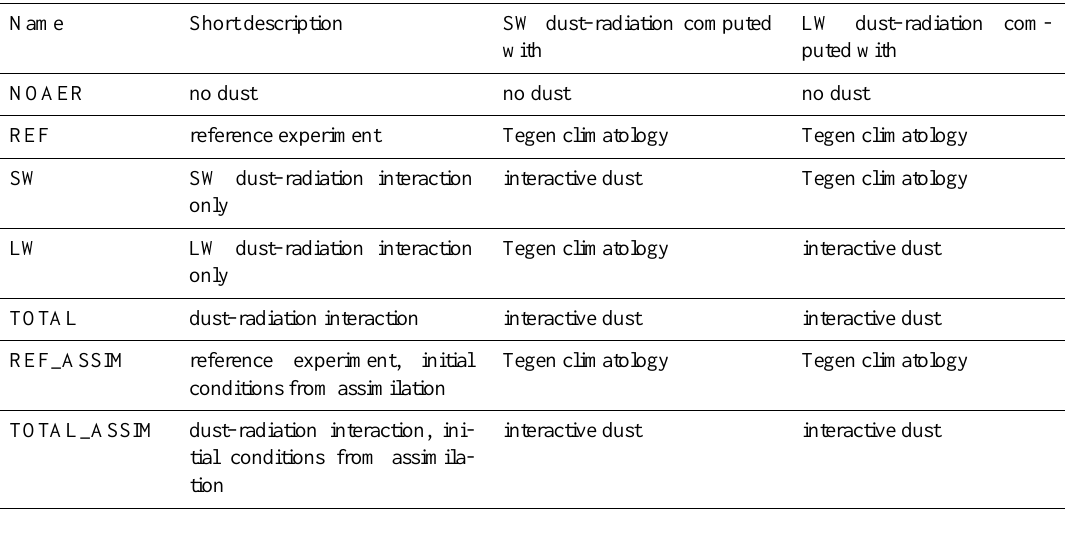
Table 1. Summary of the experiments carried out.